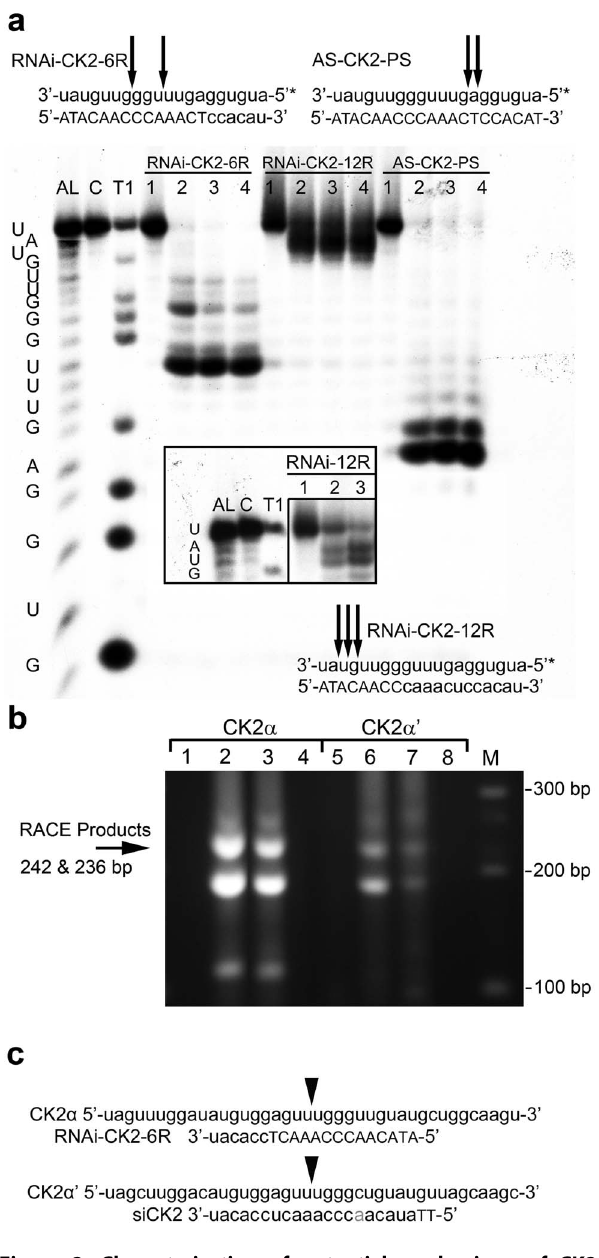
Figure 2. Characterization of potential mechanisms of CK2 expression downregulation by s50-TBG-RNAi-CK2. ( a ) RNase H1 substrate testing of different DNA/RNA composition forms of RNAi-CK2 oligomers. 5 9 end-labeled (*) RNA probe was annealed with RNAi-CK2- 6R, RNAi-CK2-12R or AS-CK2-PS complementary oligomers, then incubated for various periods of time with RNase H1. The letters on the left-hand side of the gel and inset represent the sequence ladders for the 5 9 end-labeled RNA substrate. Sizing ladders are indicated as AL (alkaline lysis), C (minus RNase T1), and T1 (RNase T1 cleavage). RNase H1 digestion times are 0, 30, 60 and 120 s (lanes 1–4, respectively). The identity of the test oligomer is indicated above the lanes. The inset shows a lighter exposure of the RNAi-CK2-12R RNase H1 reaction products. Oligomers complemented with the labeled RNA probe are shown with arrowheads indicating major cleavage sites. For the RNAi- CK2-6R and RNAi-CK2-12R oligomer sequences, lower case denotes 2 9 O -methyl RNA residues and capital letters are conventional phospho- diester linked DNA residues. The AS-CK2-PS is a phosphorothioate linked DNA oligomer. ( b ) Detection of Ago2/RISC cleavage products produced by RNAi-CK2 transfection into PC3-LN4 cells. 5 9 RNA